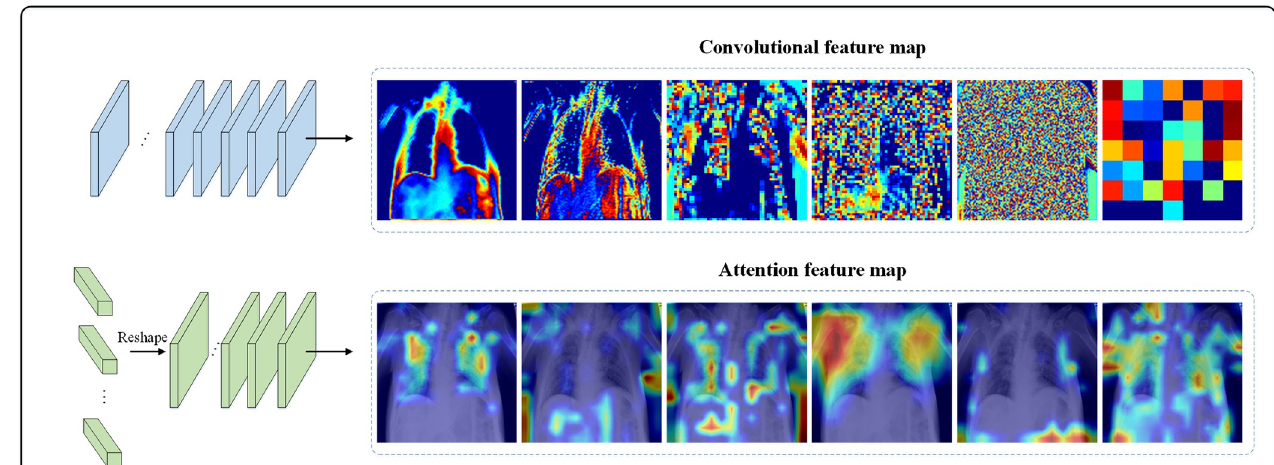
Fig 6. Feature focus sub-network.